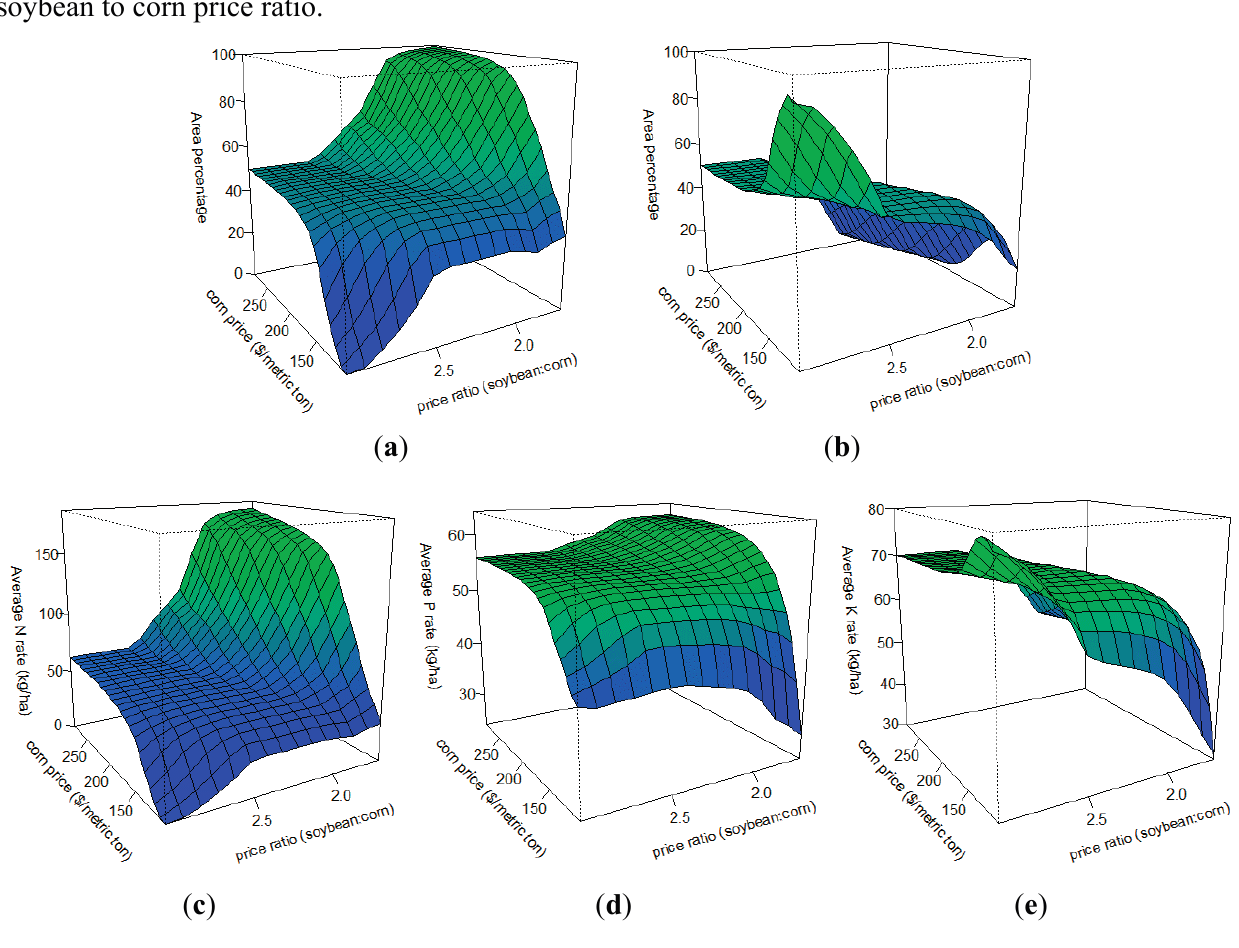
Figure 4. Simulated crop area percentage (( a ) corn; ( b ) soybean); and fertilizer rates averaged over the whole watershed (( c ) N; ( d ) P; ( e ) K) for 360 combinations of corn prices and soybean to corn price